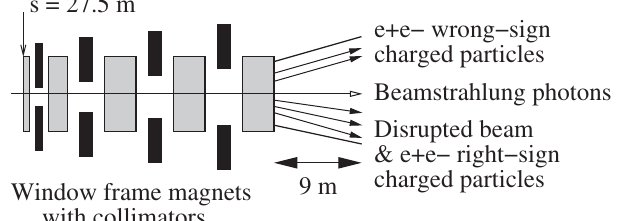
FIG. 9. Schematic layout of the first 67 m of the CLIC post- collision line, where the separation of the various components of the outgoing beam is performed.